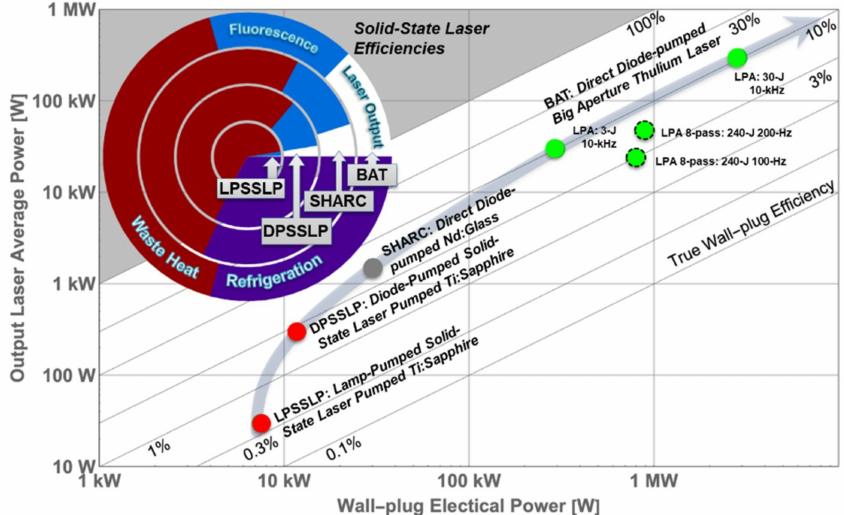
Figure 6. Wall-plug and average laser output power of various amplifier design points. The 8-pass 100 Hz and 200 Hz design points discussed in this section are outlined in black dashed lines. The 30 J 10 kHz design is the baseline BAT design described in Reference [20], while the 3 J 10 kHz design is